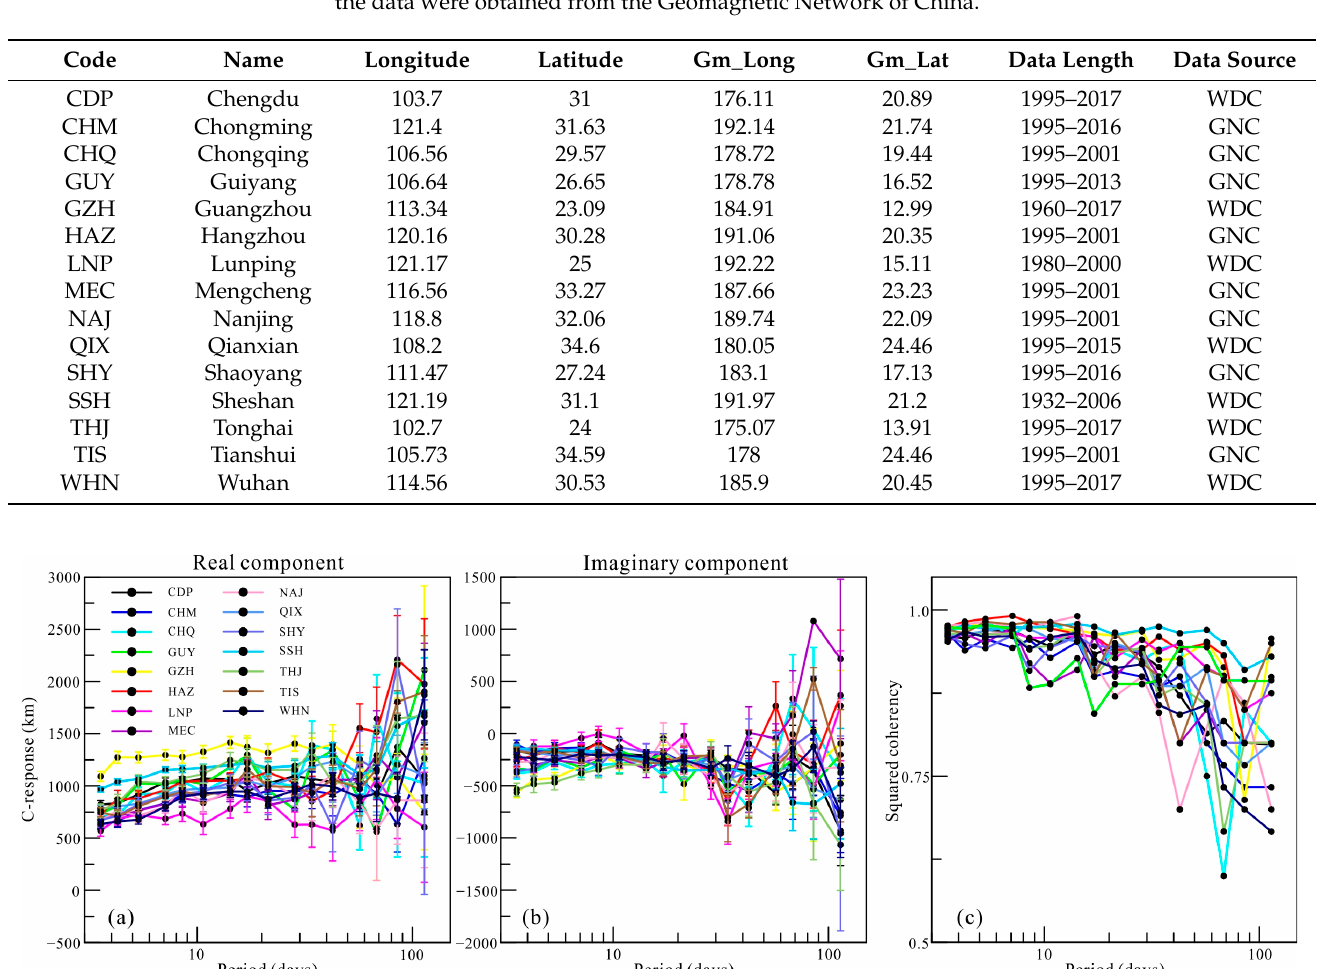
Figure 1. Locations of the selected geomagnetic observatories in South China. Table 1. Station details of the observatories used in this article. GM corresponds to the geomagnetic coordinates, and the data length is the duration of the recorded geomagnetic field data time series at the station. WDC means the data were downloaded from the World Data Center, and GNC means the data were obtained from the Geomagnetic Network of China.